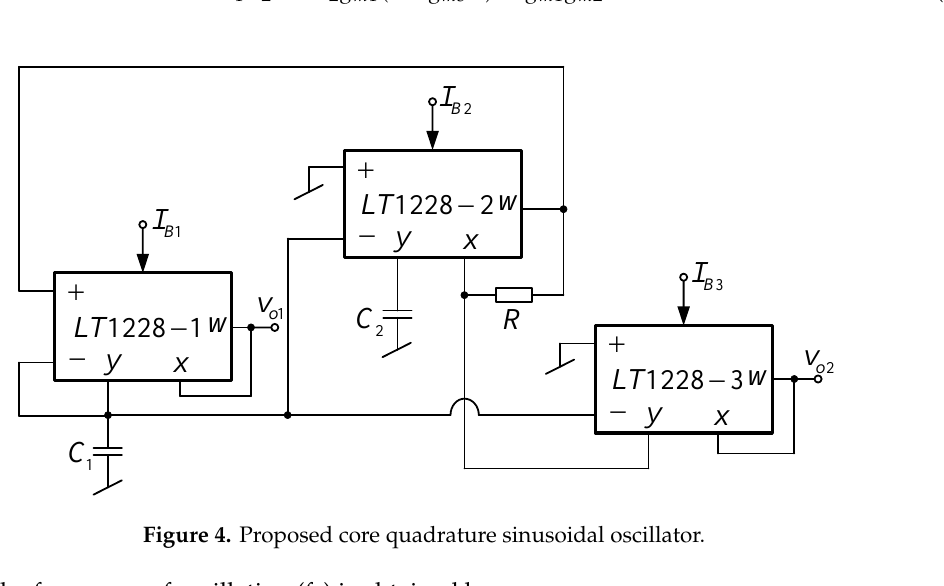
Figure 4. Proposed core quadrature sinusoidal oscillator.